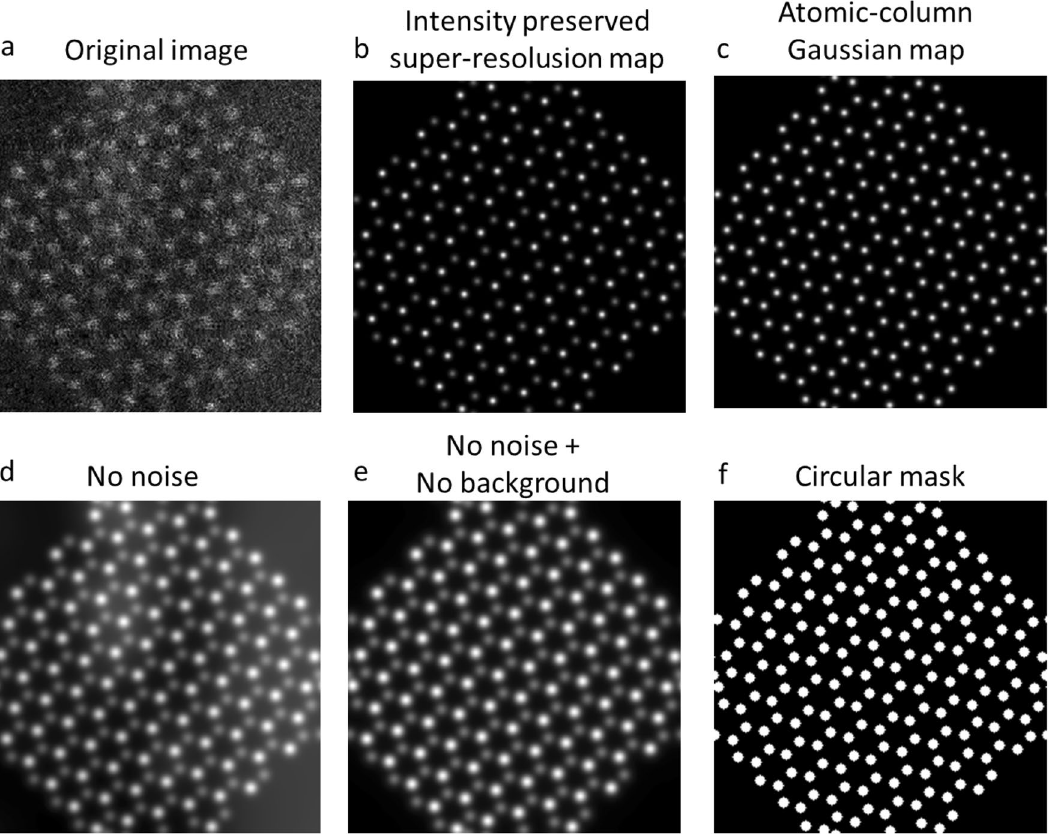
Figure 3. The ( a ) synthetic image and ground-truth labels for ( b ) intensity-preserving super-resolution (deblur) processing ( c ) atomic-column Gaussian mapping, ( d ) denoising, ( e ) denoising + background removal, ( f ) atomic-column segmentation.